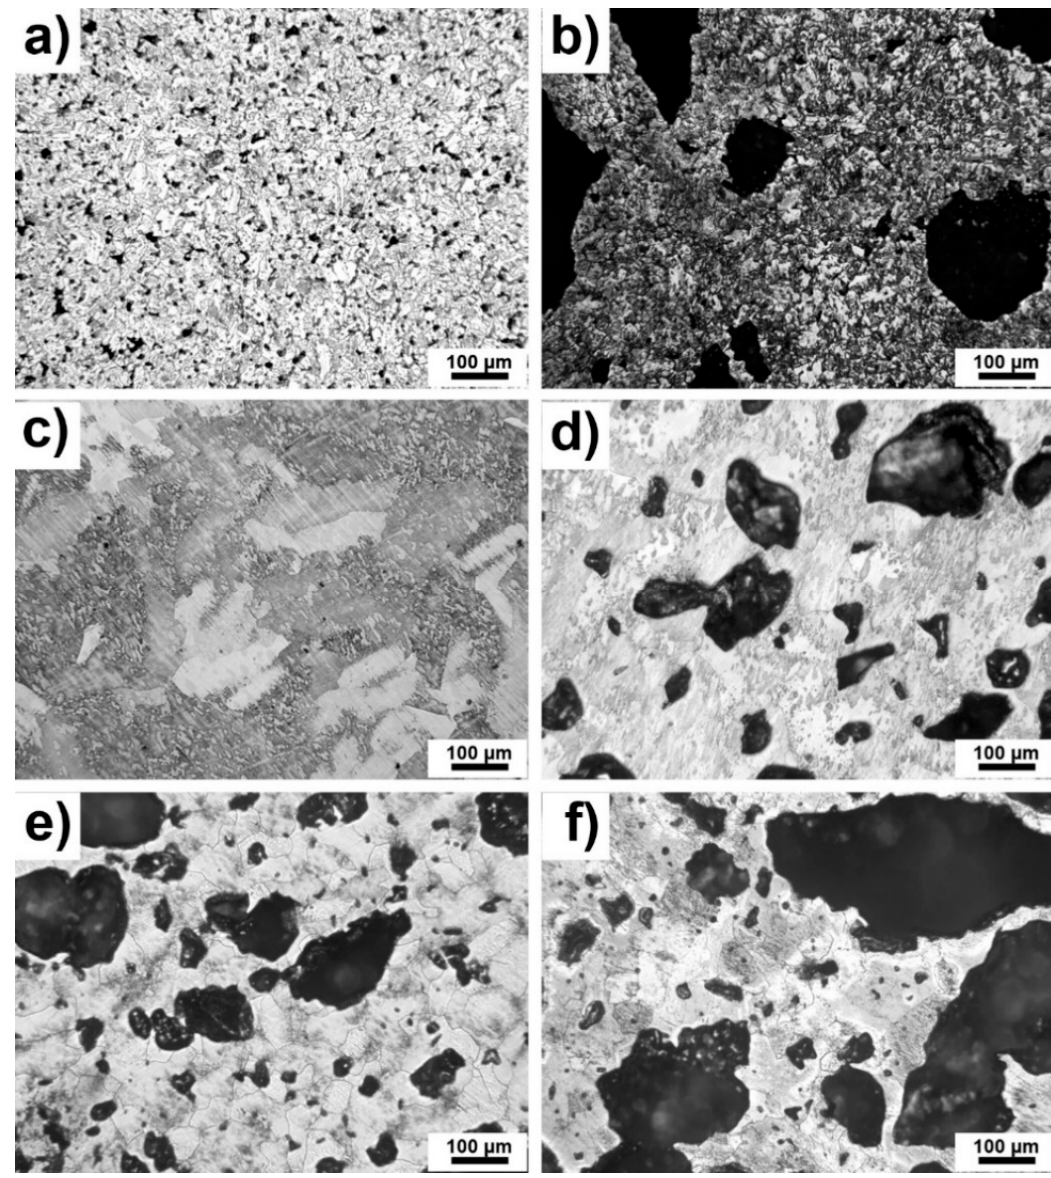
Figure 2. Microstructure of alloys ( a ) TiSi2; ( b ) TiSi2 + 20 wt.% PA; ( c ) Ti; ( d ) Ti + 20 wt.% PA; ( e ) Ti + 30 wt.% PA; ( f ) Ti + 40 wt.% PA.